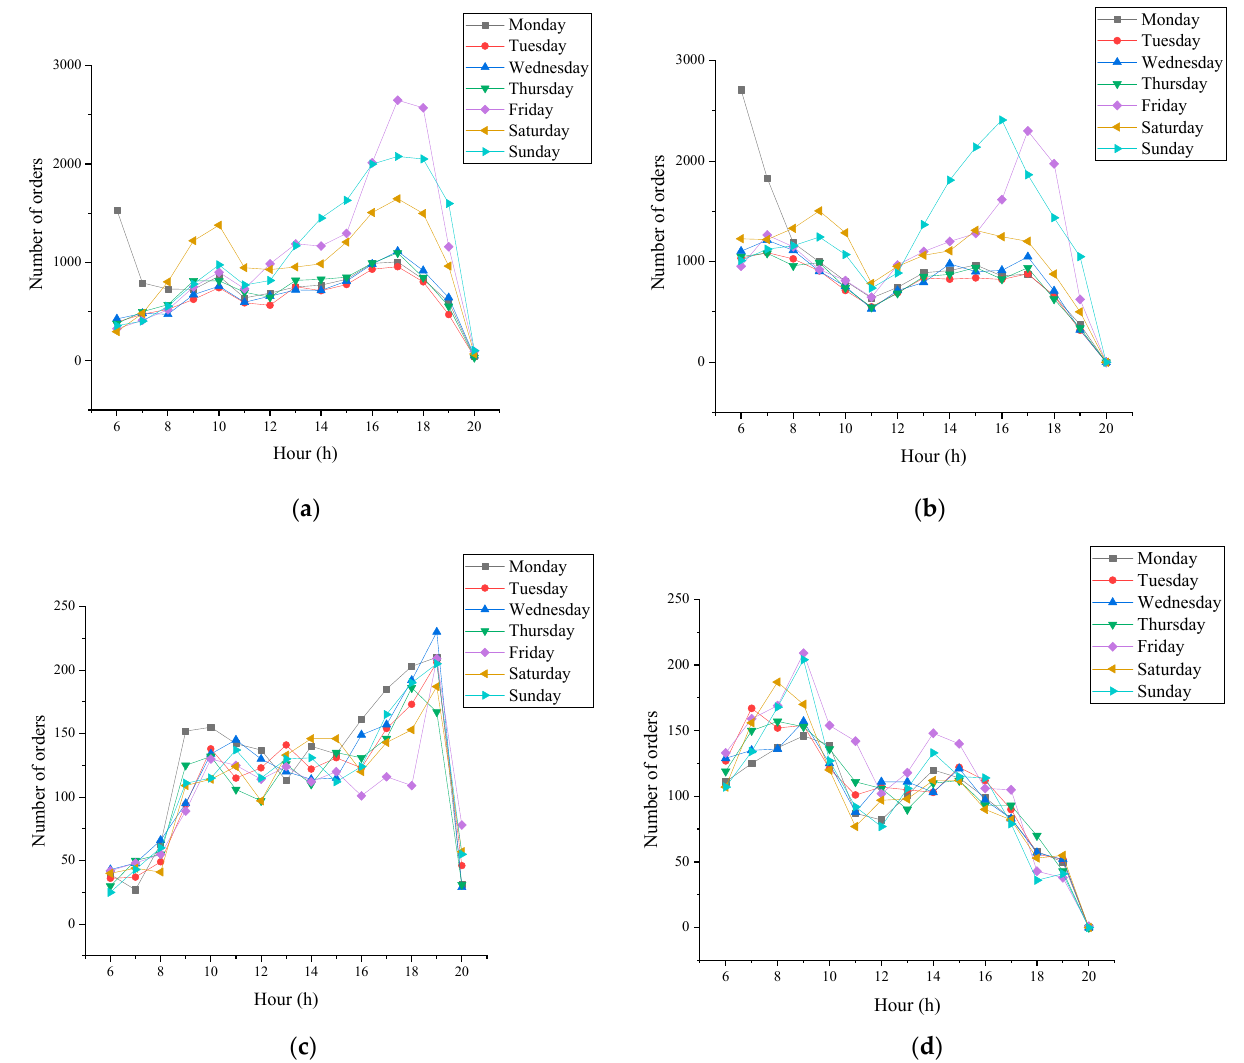
Figure 3. ( a ) Distribution of departure times for ridesplitting rides in Yinchuan; ( b ) Distribution of departure times for ridesplitting rides in Shizuishan; ( c ) Distribution of departure times for single rides in Yinchuan; ( d ) Distribution of departure times for single rides in Shizuishan.